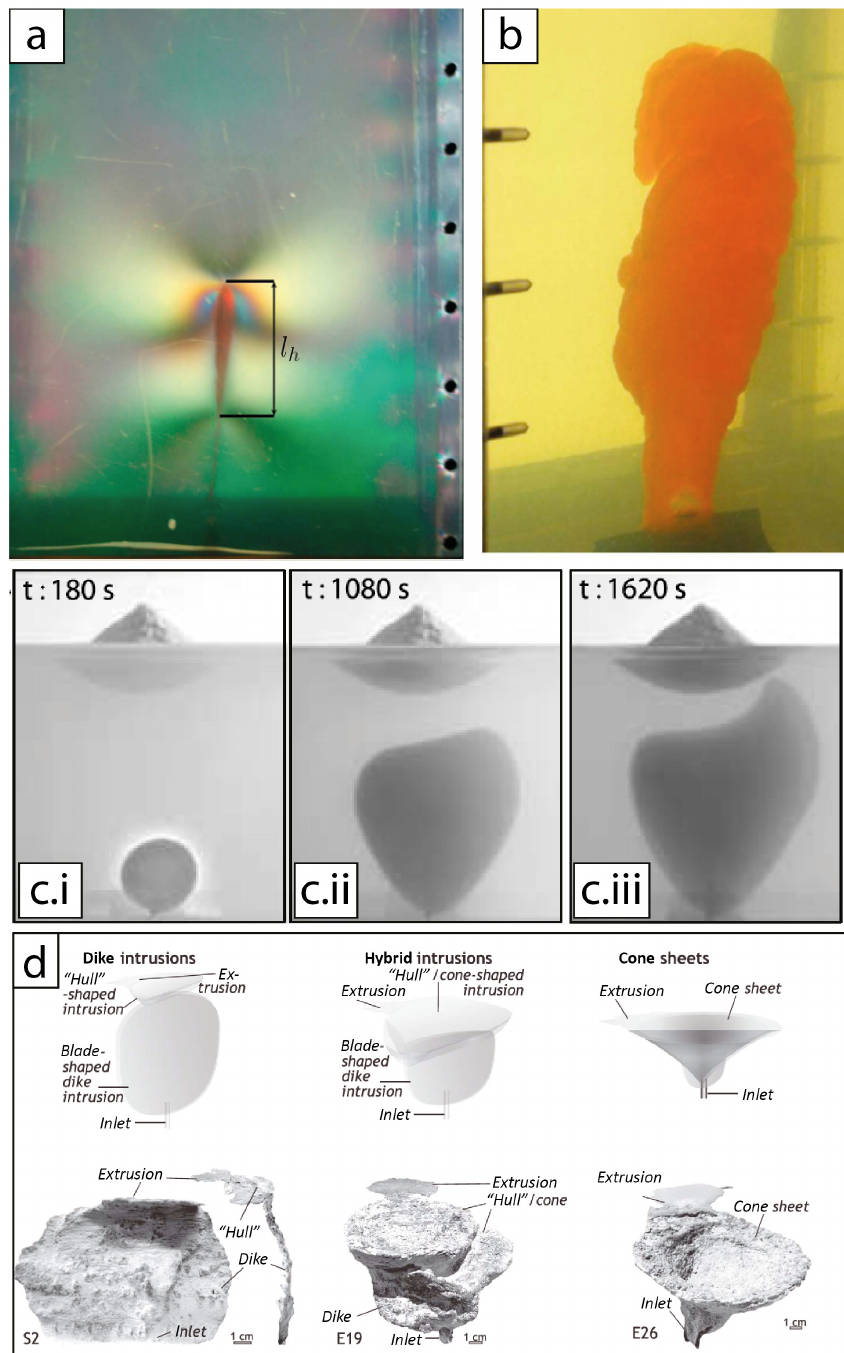
Figure 9. A series of photographs demonstrating a range of analogue experiments used to study dyke propagation dynamics. (a) Injection of red-dyed isothermal heptane into a gelatine solid, with l h indicating the length of the dyke’s buoyant head (Taisne and Tait, 2011). (b) Injection of a solidifying liquid (wax) causing the formation of an irregular and lobed dyke morphology (Taisne and Tait, 2011). (c) Series of photographs showing the impact of a volcanic edifice on dyke propagation: injection of dyed water into gelatine with a conical surface load of sand and plaster (Kervyn et al., 2009). (d) Schematic sketch and detailed photographs of excavated Vegetaline intrusions such as dykes, hybrids, and cone sheets formed within compacted silica flour experiments (Galland et al., 2014).